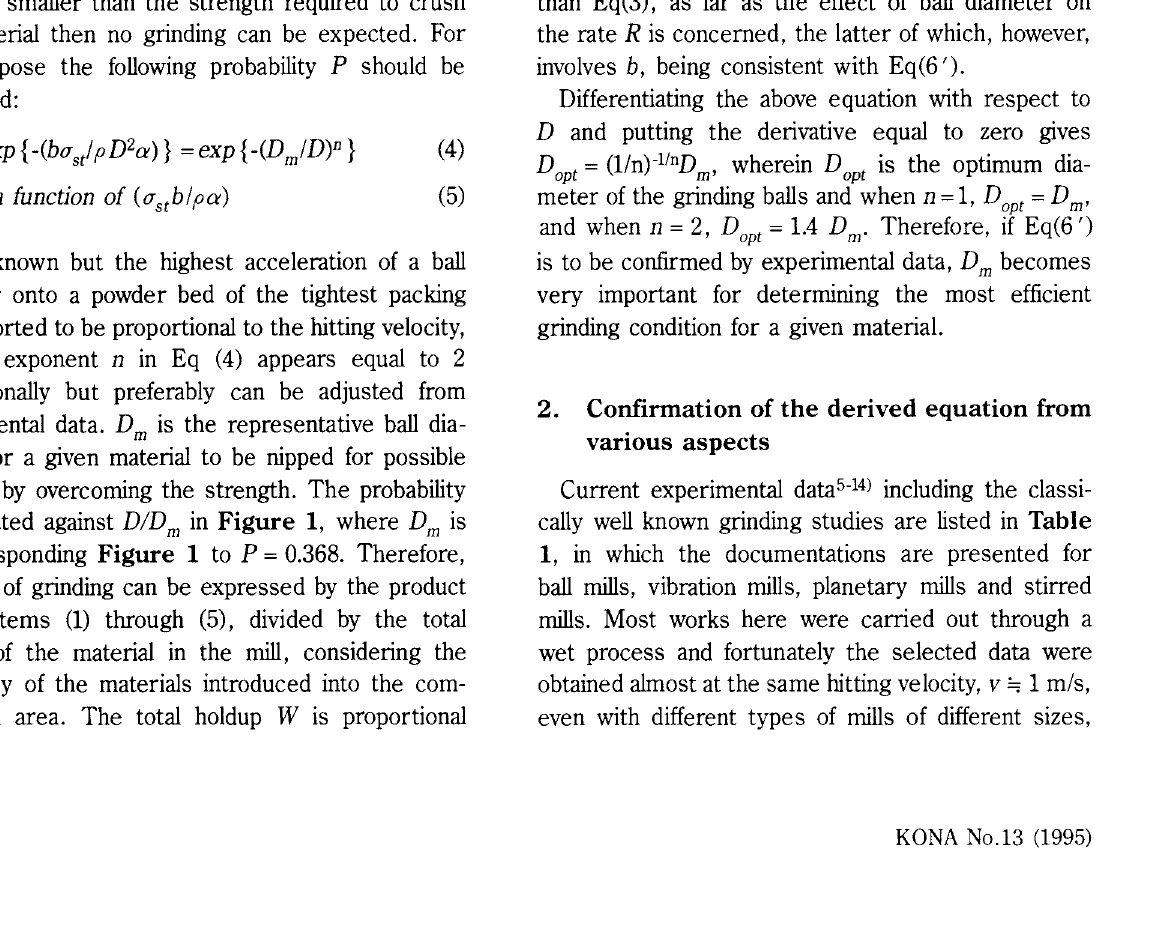
Fig. 1 Grinding probability vs. ball diameter divided by D